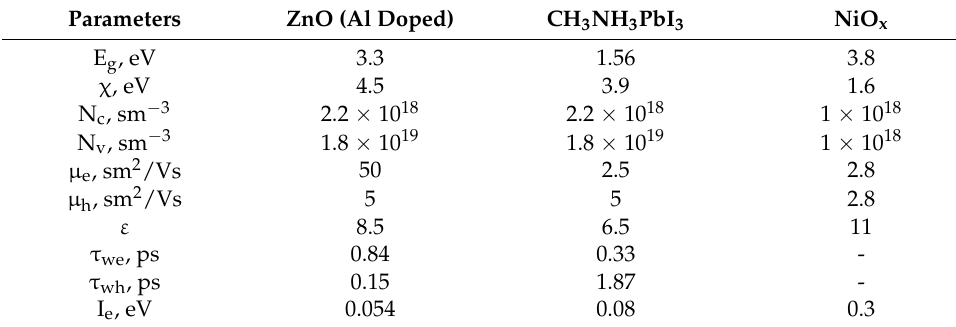
Table 1. Physical parameters of ZnO [30–34], CH 3 NH 3 PbI 3 [35–39], and NiO x. [40].